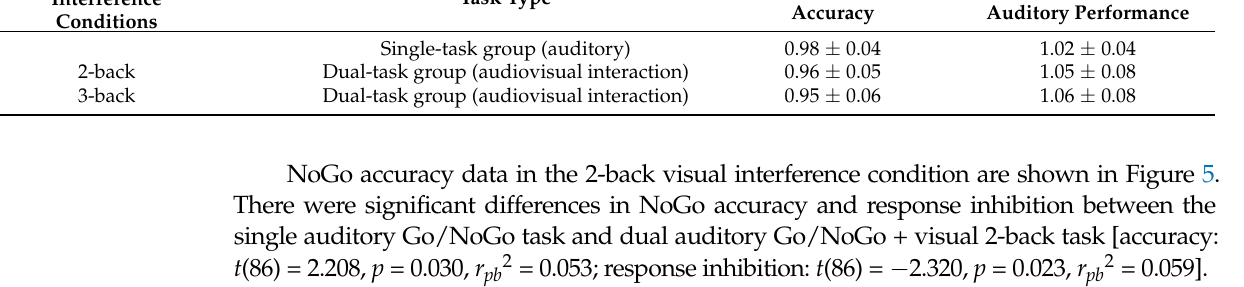
Figure 6. In visual 3-back interference conditions, ( a ) single-task (auditory) and dual-task (audio- visual interaction) groups for accuracy (ACC); ( b ) single-task (auditory) and dual-task (audiovisual